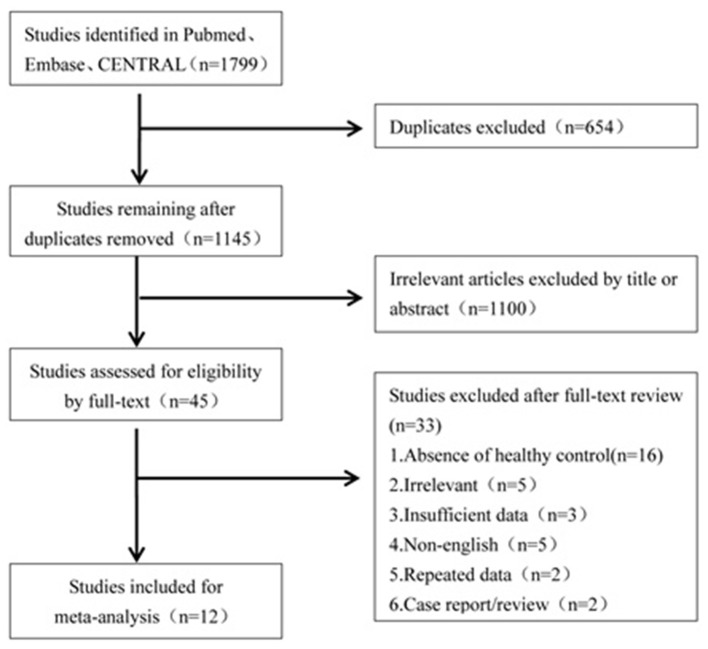
Flowchart of data search and studies selection for meta-analysis.